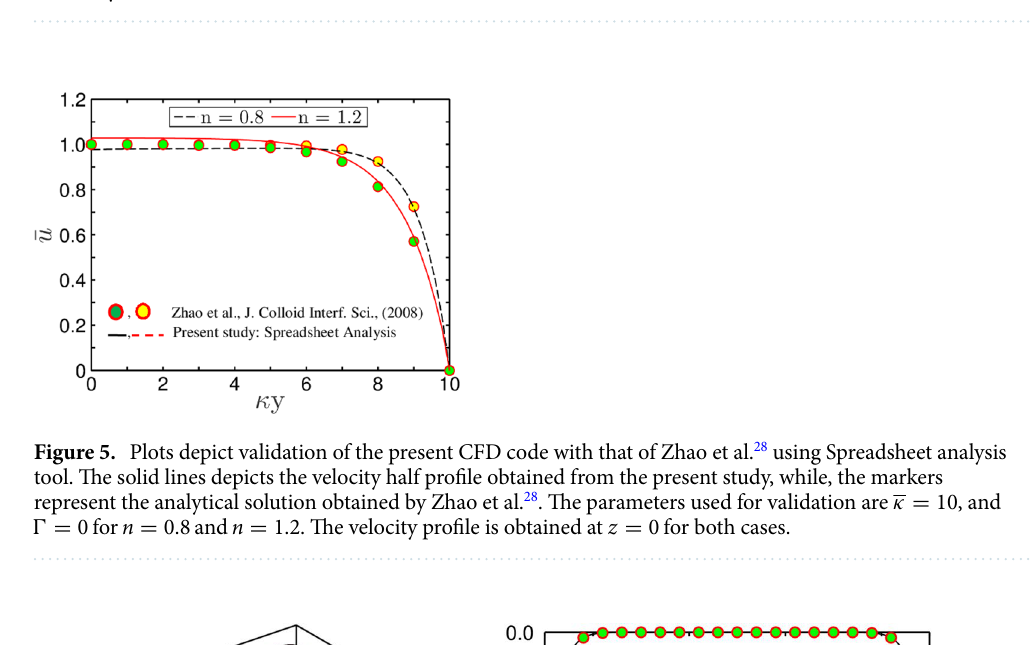
Figure 4. ( a ) Plots depict velocity profile at different instances of time at z = 0 and ( b ) Plots depict steady state velocity profile at z = 0 . The parameters used for these variations are κ = 10 , and Ŵ = 0 for n = 1 . The analytical solutions are represented by solid lines, whereas the spreadsheet analysis tool-derived solutions are shown by markers.